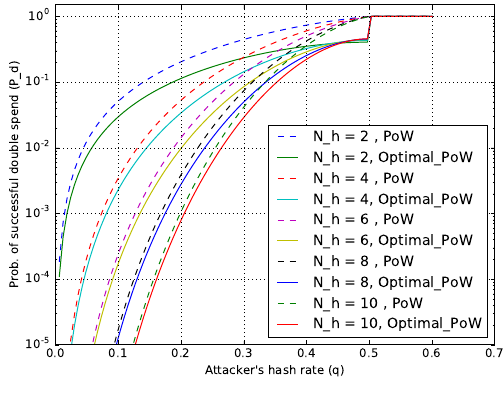
Figure 2. Attacker’s rate ( q ) Vs P d .